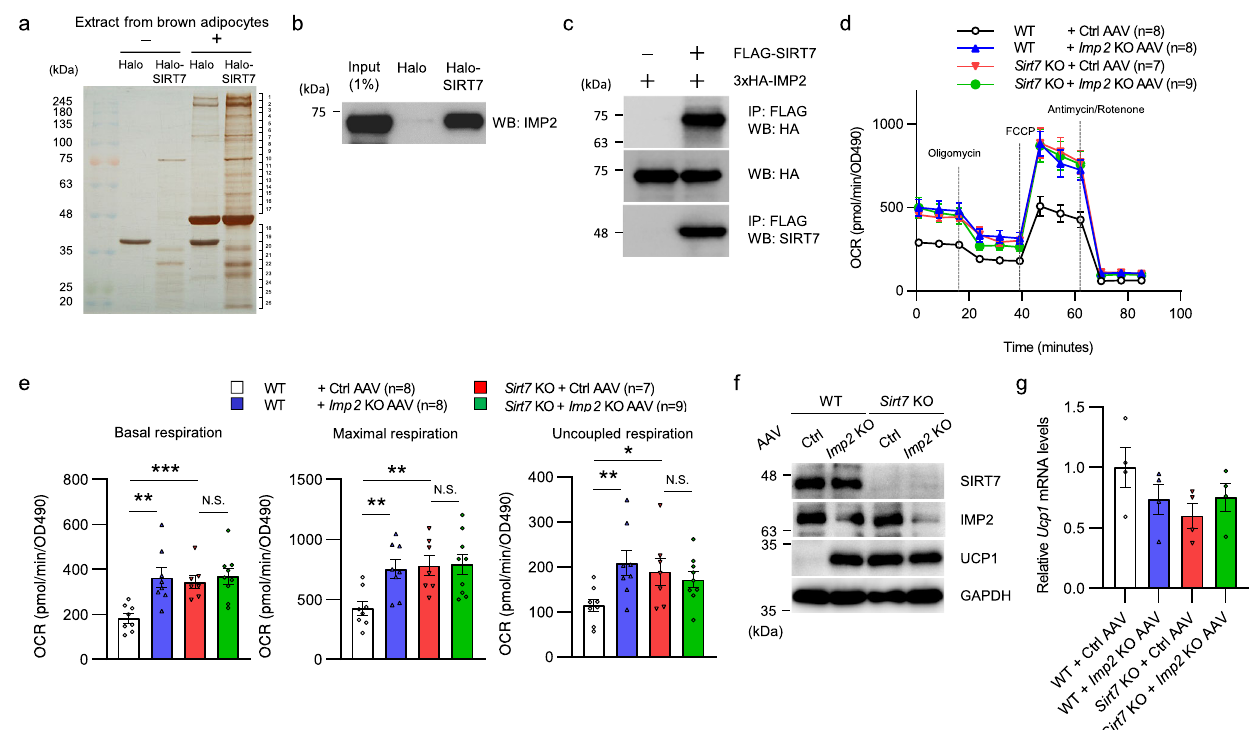
Fig. 7 | SIRT7 suppresses energy expenditure via IMP2 in brown adipocytes. a Halo-SIRT7pull-downassaywithextractsfrombrownadipocytes.Elutedproteins wereresolvedbySDS-PAGE, followedbysilverstaining.Thegellaneswerecutinto 26 pieces and the proteins within each gel piece were analyzed by mass spectro- metry. b Halo-SIRT7 pull-down assay performed with lysates from HEK293T cells overexpressing 3×HA-IMP2. Overexpressed IMP2 was detectedby WB with ananti- IMP2 antibody. c Co-IP assay detecting the interaction between FLAG-SIRT7 and 3×HA-IMP2 in HEK293T cells. d , e The effect of Imp2 de fi ciency on mitochondrial respirationindifferentiatedprimarybrownadipocytesfromWTand Sirt7 KOmice. SVF cells were infected with the indicated recombinant AAV and differentiated for 9 days. Time course OCR ( d ) and quanti fi cation of mitochondrial respiration ( e